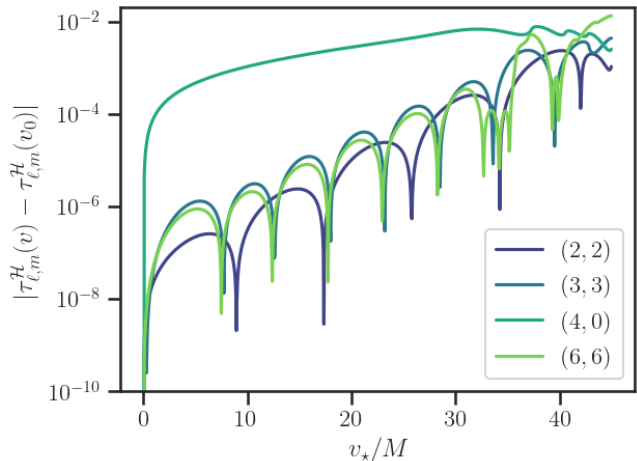
Figure 7 . Dependence of the decay time τ H different modes, as indicated in the